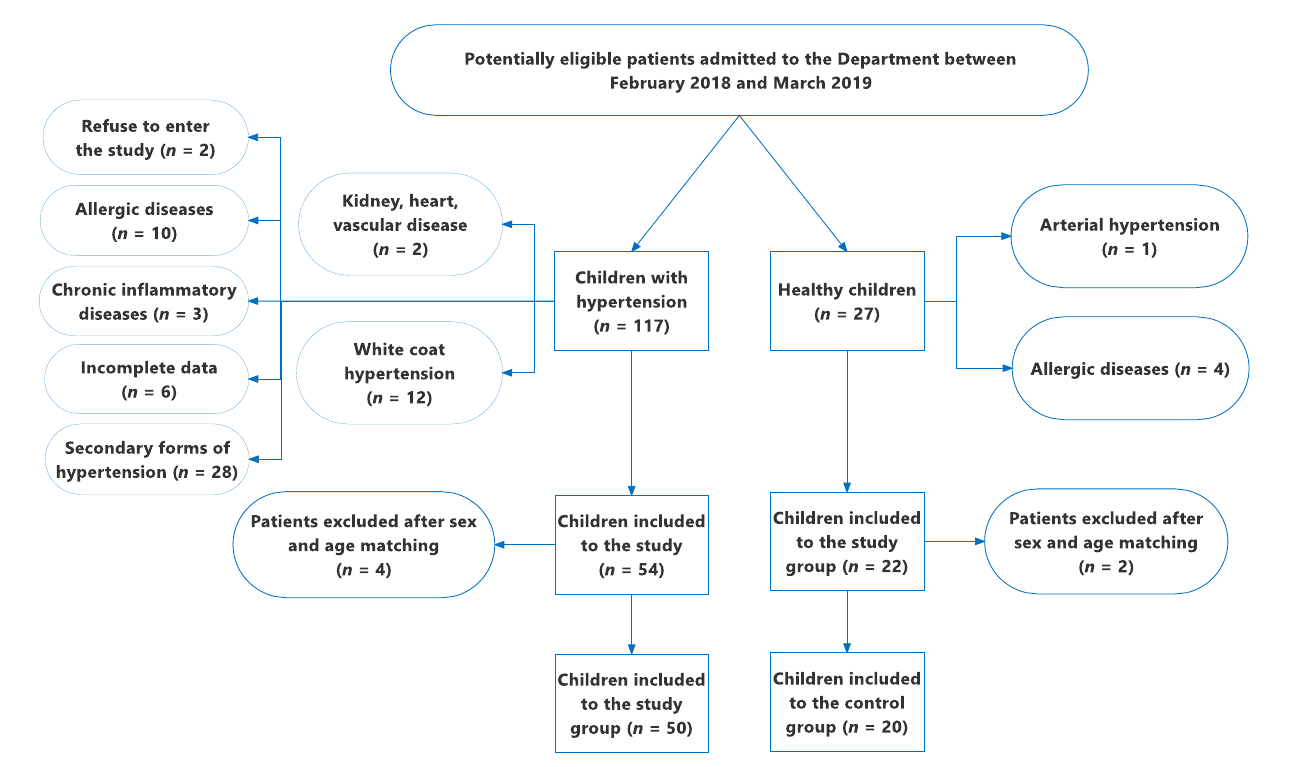
Figure 1. Flow diagram of the patients’ recruitment.